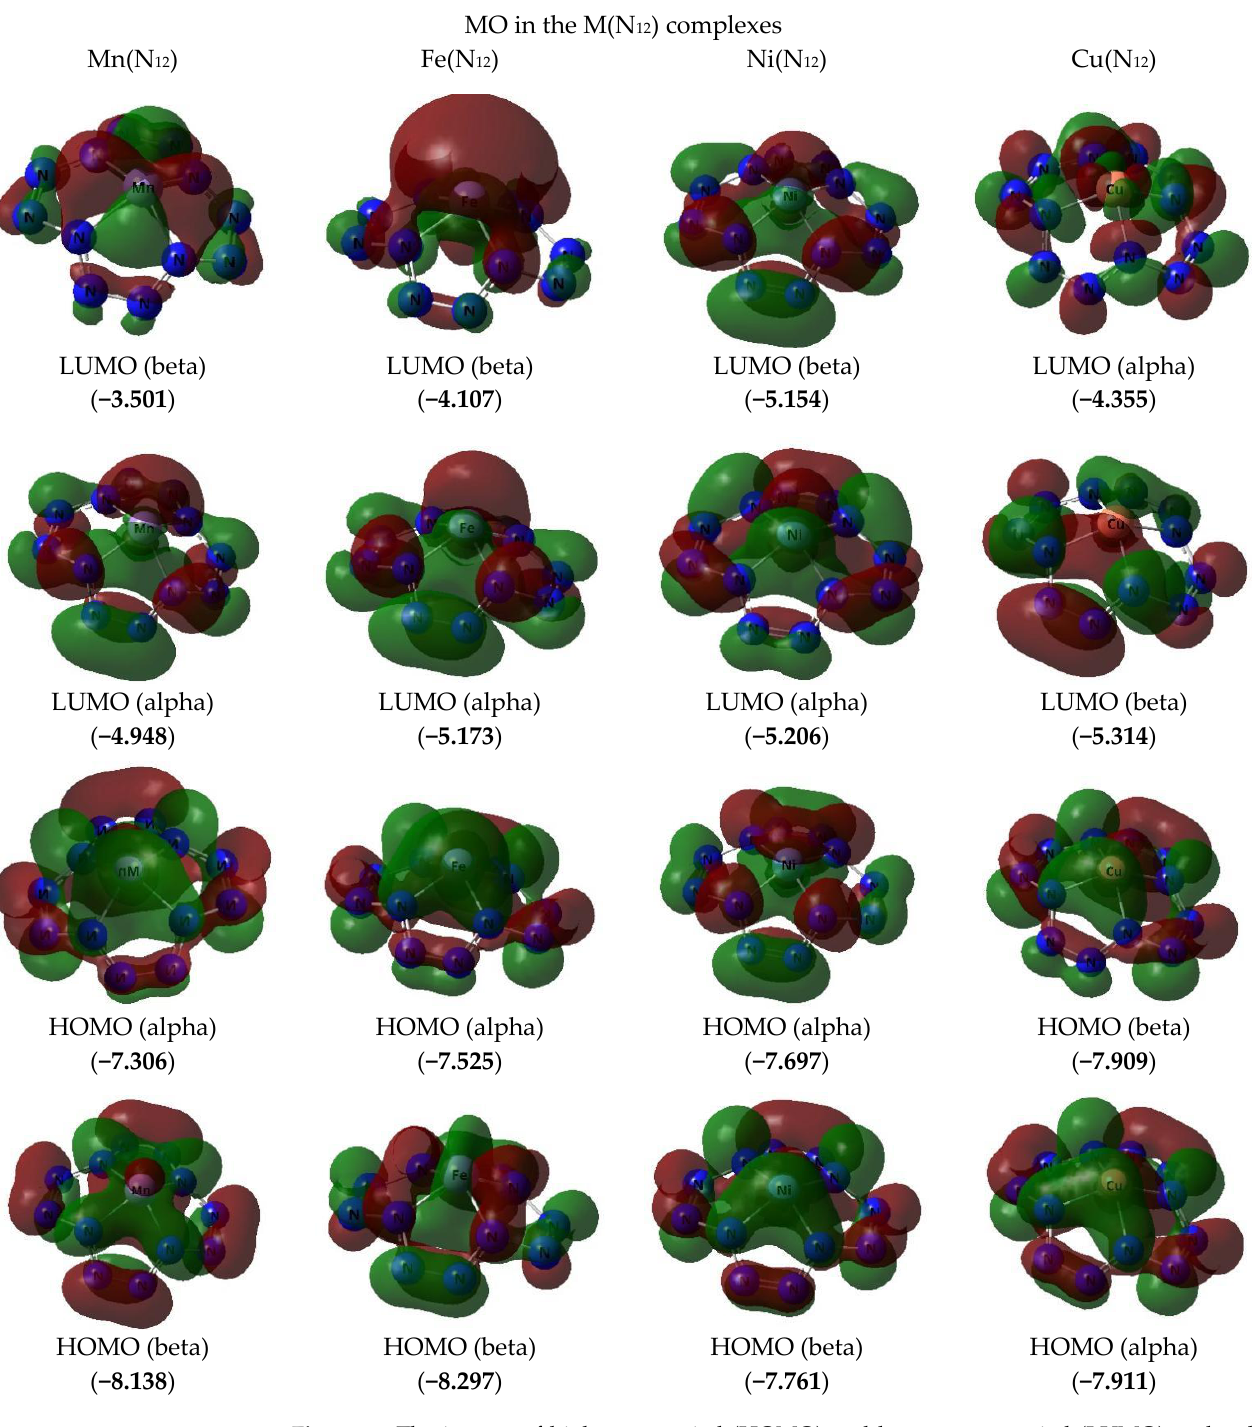
Figure 2. The images of highest occupied (HOMO) and lowest unoccupied (LUMO) molecular or- bitals in the M(N 12 )] complexes of group A obtained by DFT M06/TZVP method. The values of en- ergies of these molecular orbitals (in brackets) are given in eV. The symbol “alpha” corresponds to electron with spin (+1/2), “beta”, to electron with spin (−l/2).